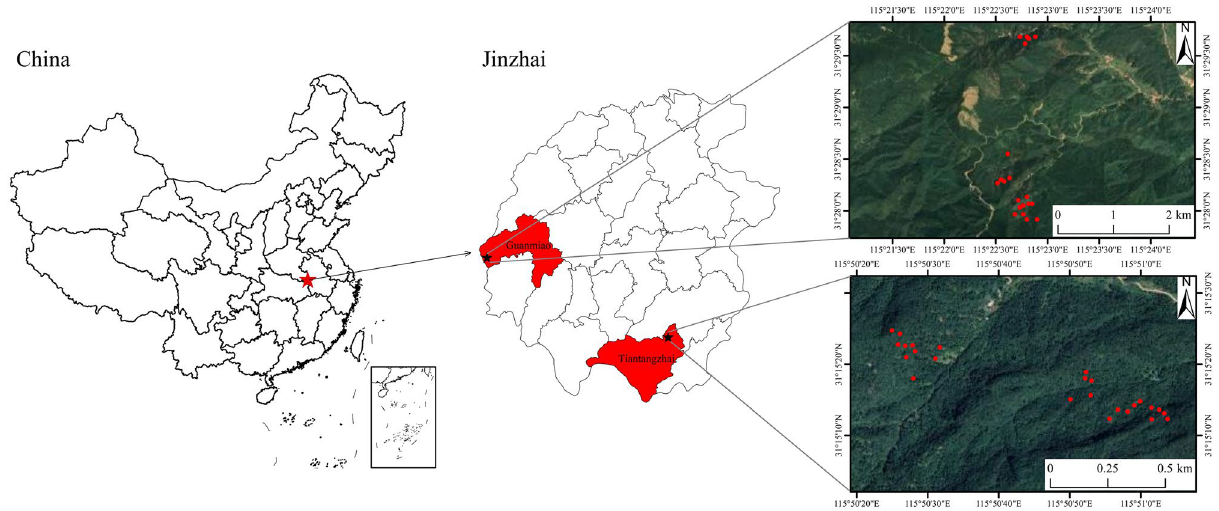
Figure 1. Map of the study area. Note: maps and satellite imagery were generated using the ArcGIS10.8 software from American ESRI Company. https:// suppo rt. esri. com/ en/ Produ cts/ Deskt op/ arcgis- deskt op/ sample plots in each, for a total of 45 sample plots. For each plot, a 20 × 20 m section was randomly established to represent the forest stand, and all plots were set on the north slope (20–30°) of the mountain at > 100 m from the road and farmland. To reduce spatial autocorrelation, the distance between each forest area was > 500 m, and the distance between each plot was > 100 m. The operation data for all forest areas were obtained from the management records of Xiyuan Carya dabieshanensis Professional Cooperative and Jinzhai County Tongchuang Carya dabieshanensis Development Co., Ltd. Soil samples were collected from the test site in July 2022. Following the removal of plants and litter from the surface of each plot, soil samples were extracted according to the "S" sampling method using a 100 cm 3 ring knife. For each tree community a topsoil (0–30 cm) sample was collected, and each was divided into three soil layers (0–10 cm, 11–20 cm, and 21–30 cm). This sampling technique was repeated for each layer, where samples from the same soil layer following the removal of fine root and stones were mixed into new samples, for a total of 135 mixed soil samples were collected. All soil samples were sealed and transferred to the laboratory at low temperature and stored at 4 °C in a freezer pending the detection of soil enzyme activities, as well as physical and chemical properties.